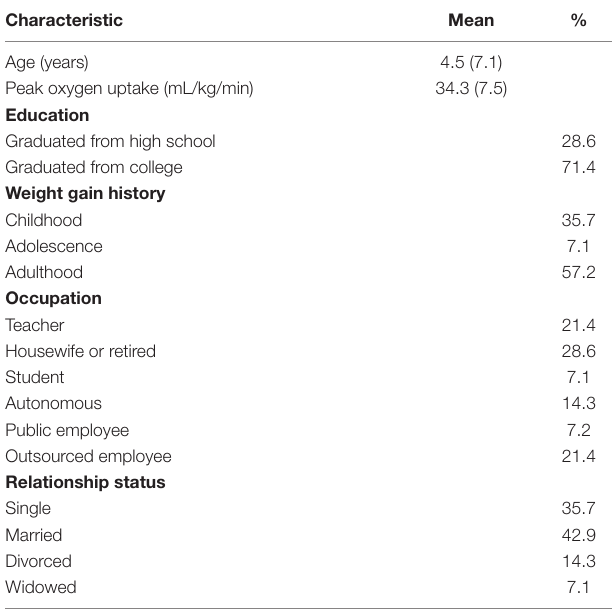
size ® philosophy ( n =